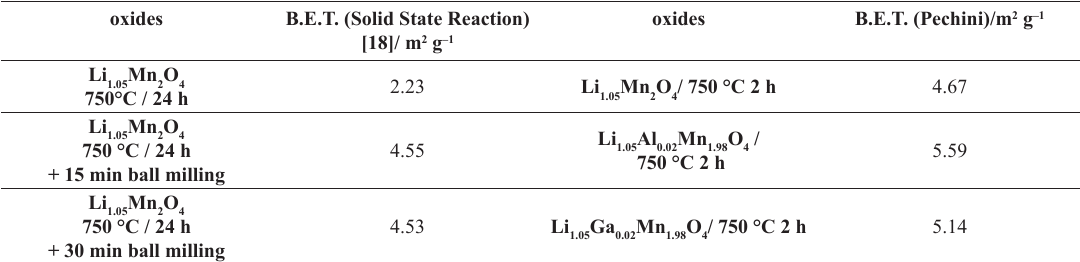
Mn O ; (b) and (e) Li 1.05 2 4 Mn O obtained by different synthesis 1.05 2 4